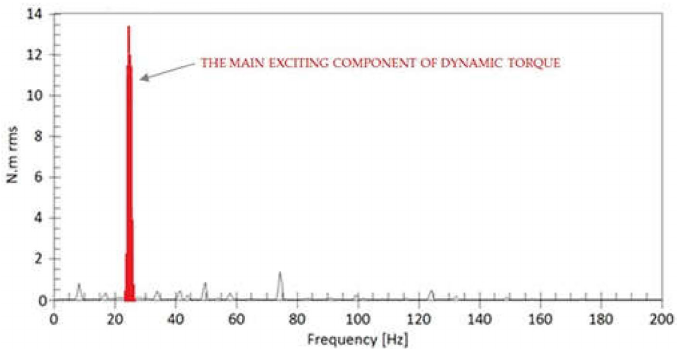
Figure 6. Frequency amplitude spectrum without deactivated cylinders in the compressor.